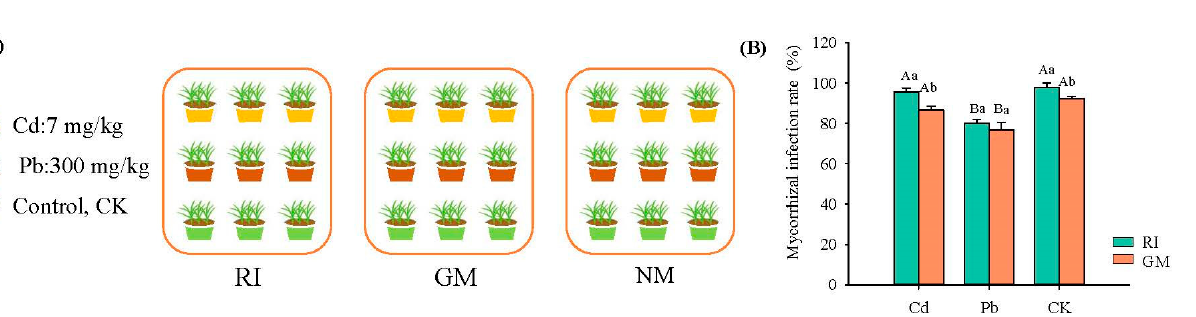
Figure 1. Experimental design ( A ) and infection rates of arbuscular mycorrhizal fungi ( B ) under different heavy metal stress. Note: Capital letters in figure ( B ) represent the difference between different heavy metal treatments in the same AM fungi inoculation. Lowercase letters represent the differences between different AM fungi inoculation under the same heavy metal treatment.